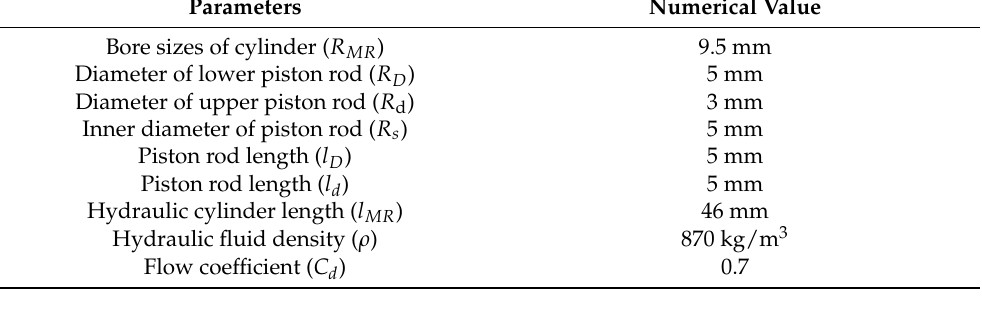
Figure 7. The parameters of the hydraulic cylinder. Table 1. The values of the parameters in simulation